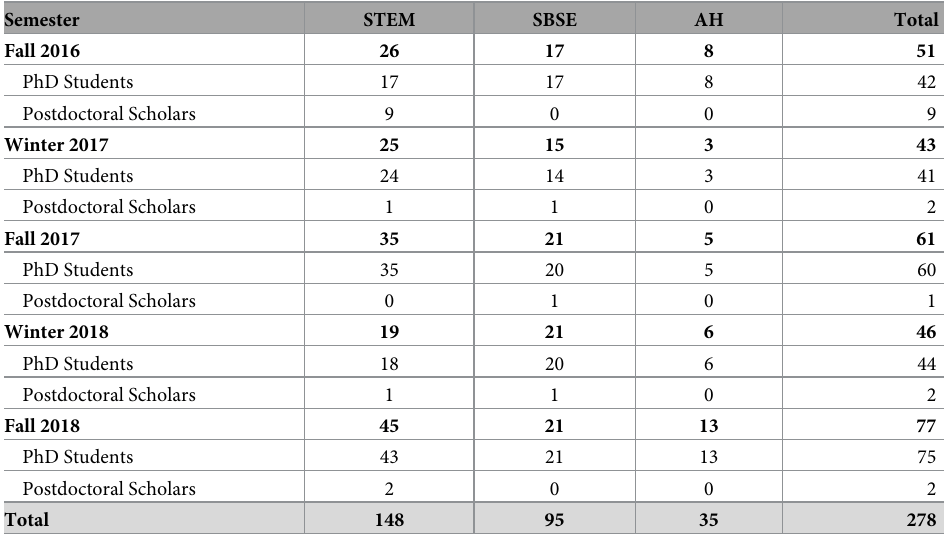
Table 2. Student survey responses by